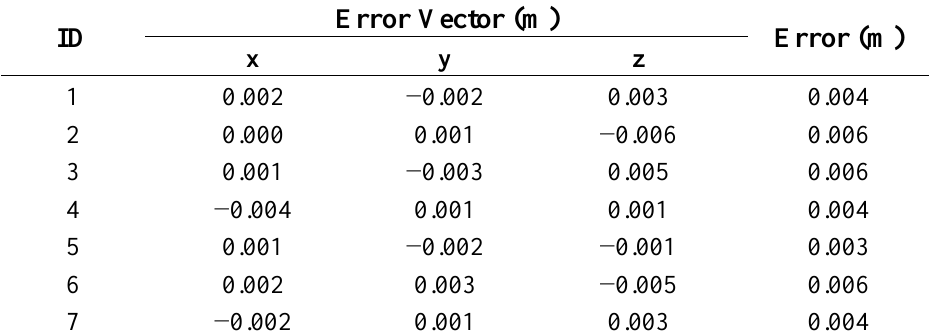
Table 2. Registration errors recorded in the acquisition of February 2012.